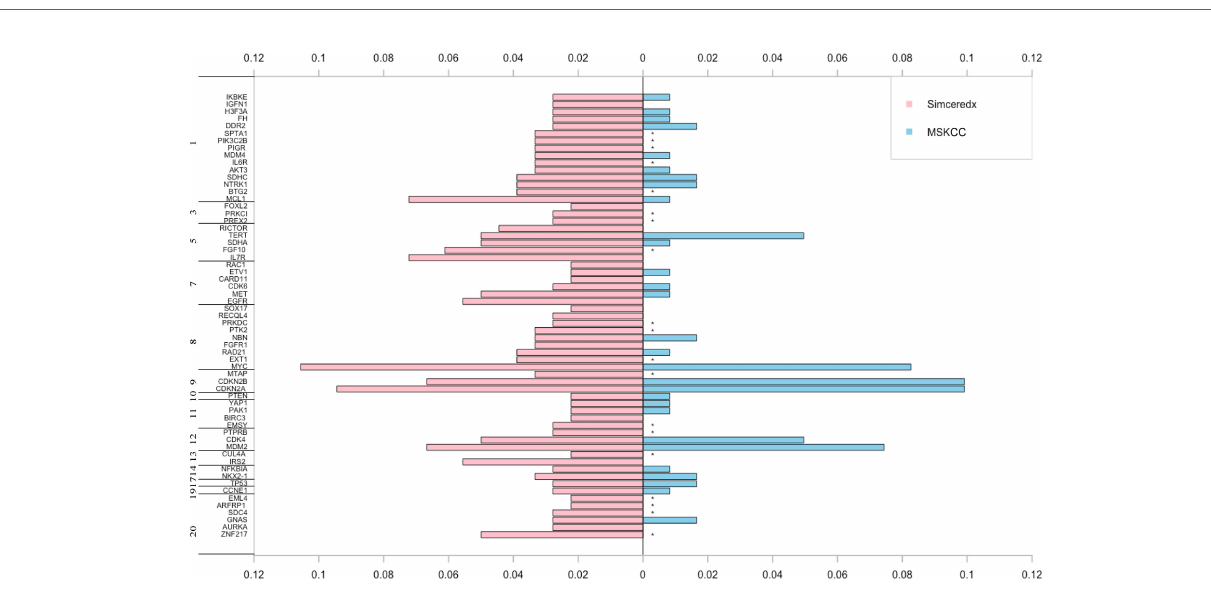
FIGURE 6 | The pink and blue bars represent CNV events occurring in ALK/ROS1/NTRK fusion-positive patients in our cohort and MSKCC cohort, respectively. *represents the genes not covered in the MSKCC